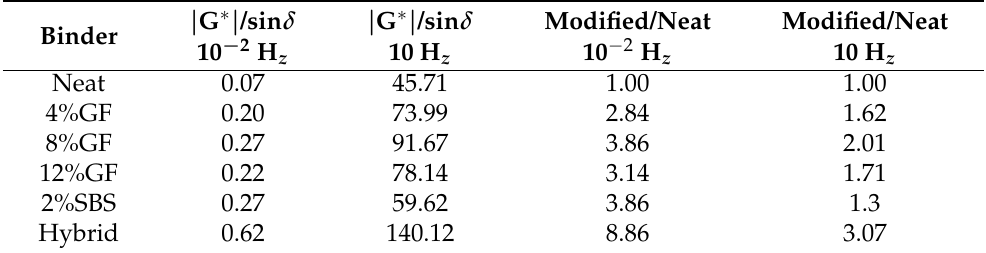
Figure 7. Temperature’s effect on the rutting factors of neat and modified asphalt binders at 10 rad/s. Table 9. Frequency effects on the rutting factors of neat and modified asphalt binders.